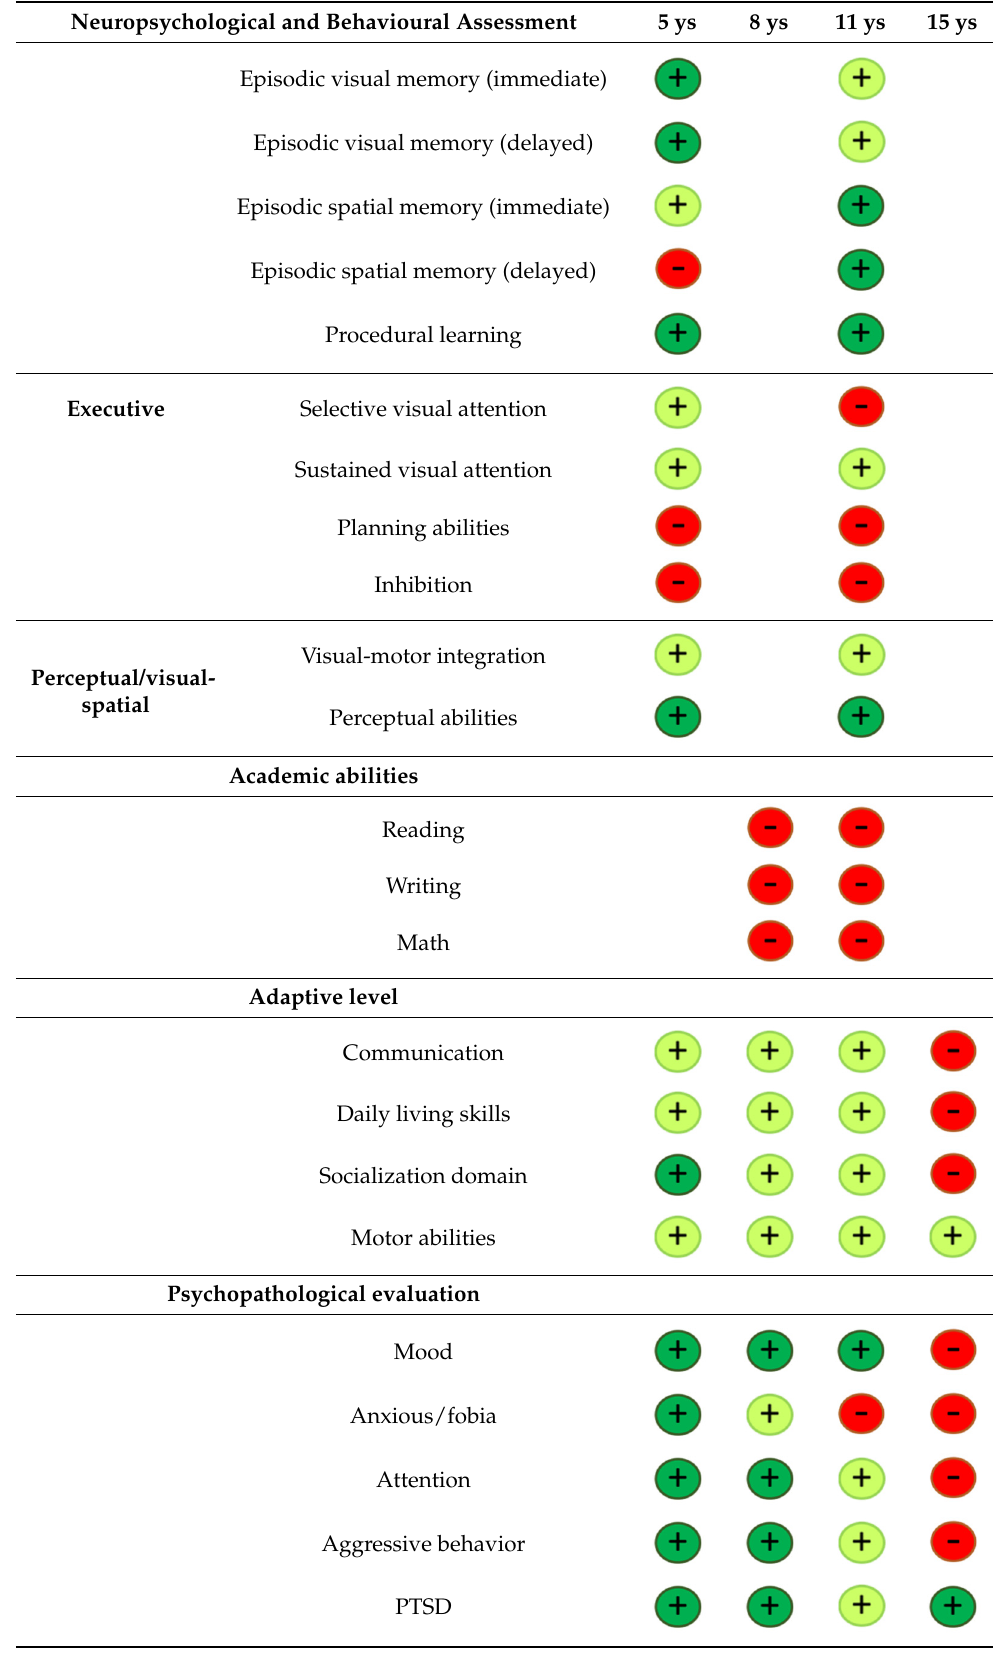
Table 2. Cont. Neuropsychological and Behavioural